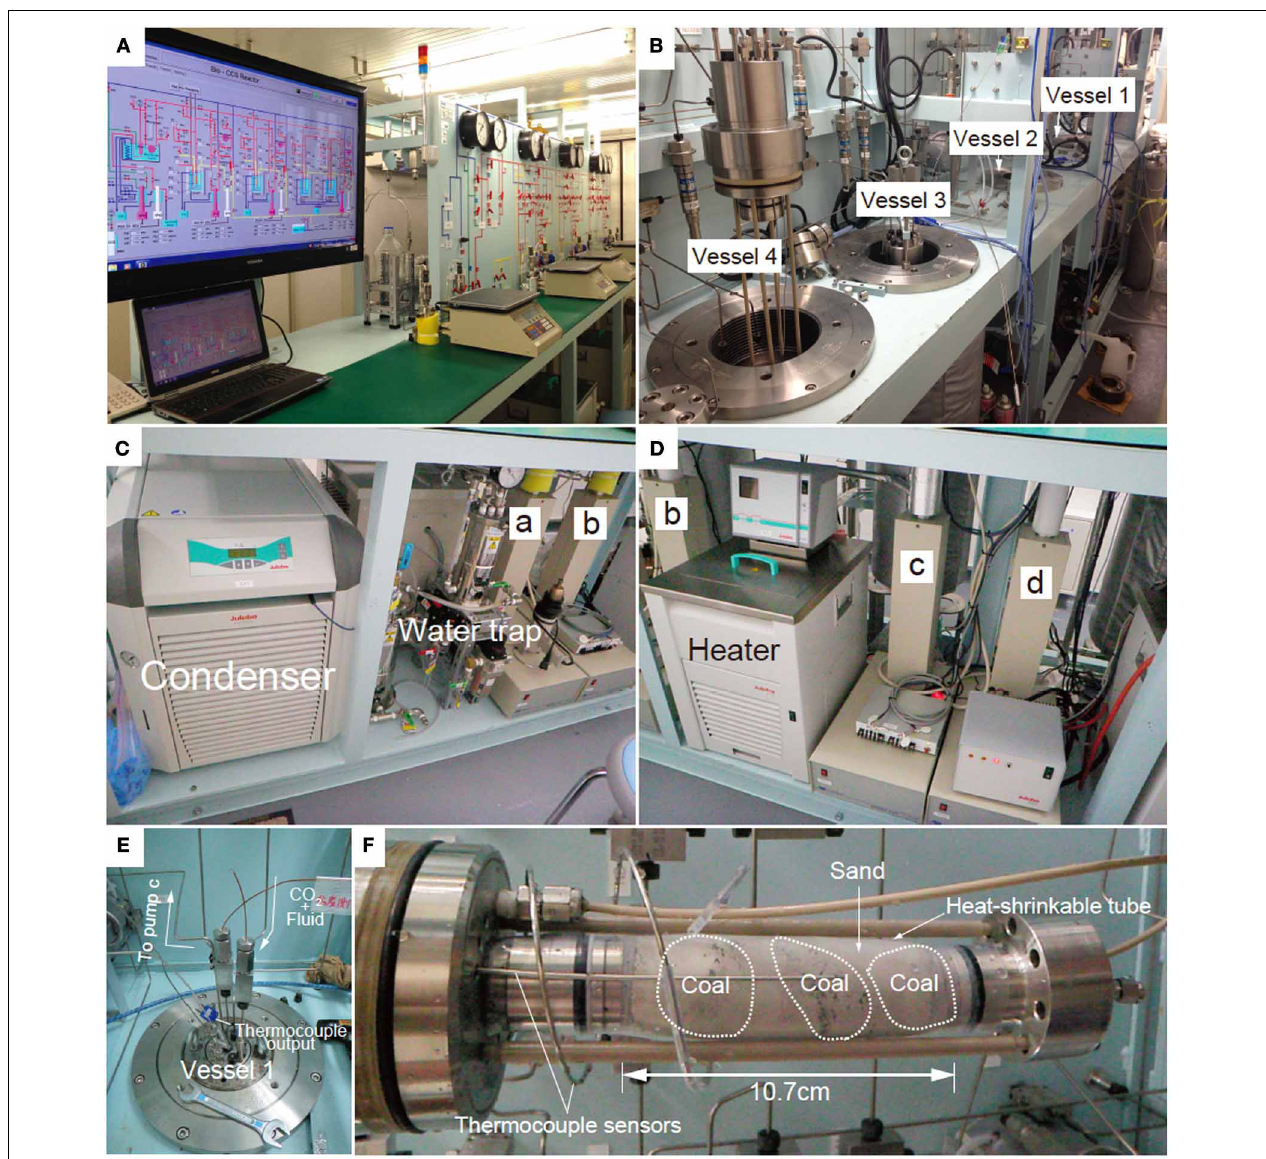
FIGURE 2 | Photographs of the geobio-reactor system. (A) Photo of the entire system, (B) Photo of the four vessels, (C) Cylinder pumps for CO 2 and fluid supply (pumps a and b). CO 2 passes through a chiller which keeps the CO 2 in the liquid phase until it reaches the pump a. (D) Cylinder pumps for sub-sampling and controlling confined pressure of the vessel (pumps c